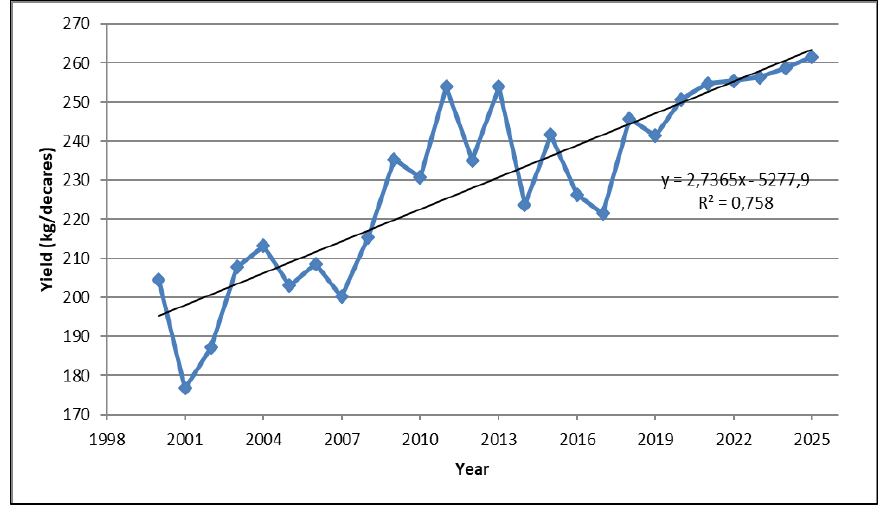
Figure 6: Oats yield in Turkey (2000-2025).